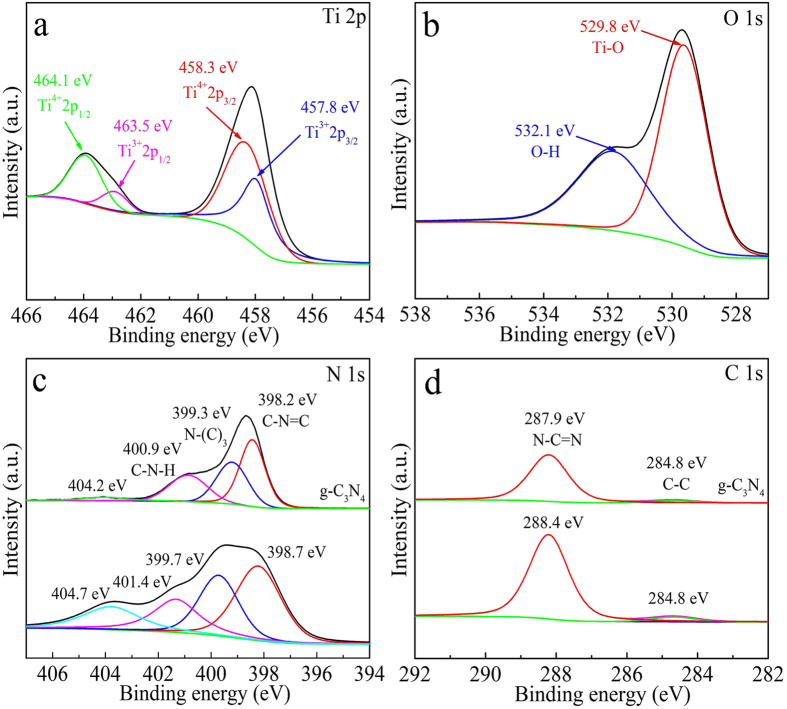
XPS spectra of Ti 2p spectra of b-TiO2/g-C3N4 (a), O 1s spectra of b-TiO2/g-C3N4 (b), N 1s spectra of g-C3N4 and b-TiO2/g-C3N4 (c), and C 1s spectra of g-C3N4 and b-TiO2/g-C3N4 (d).